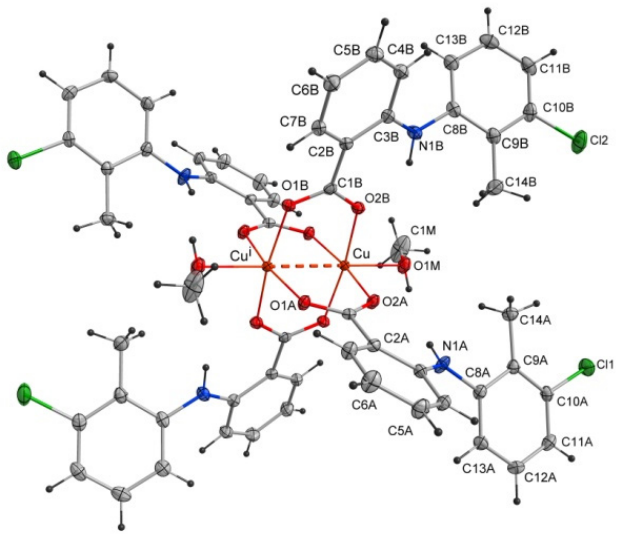
Figure 2. Structure of the coordination compound of [Cu II 2 (Tolf) 4 (MeOH) 2 ] · 2MeOH. For clarity, uncoordinated methanol molecules were removed. The dashed line shows the distance between copper(II) ions. Symmetry code: i = − x + 1, − y + 1, − z + 1. Selected bond lengths and angles are presented in Tables 2 and 3. The structure reveals